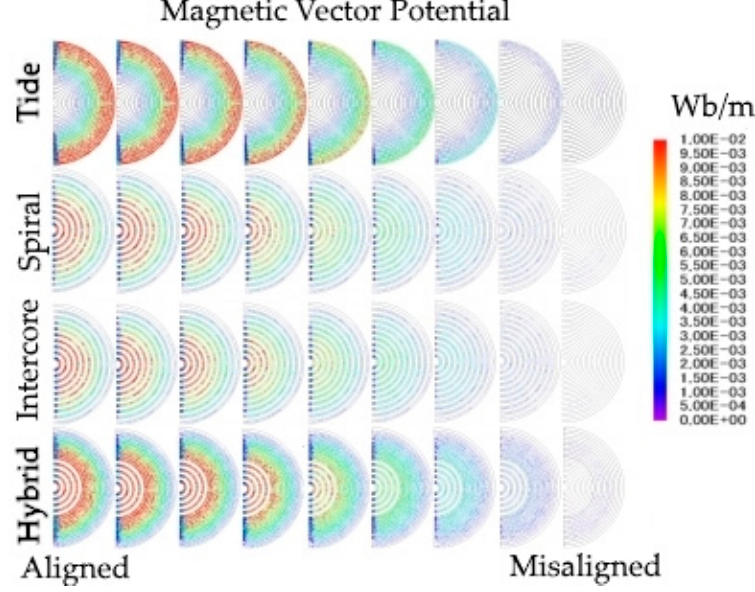
Figure 16. Magnetic vector potential.